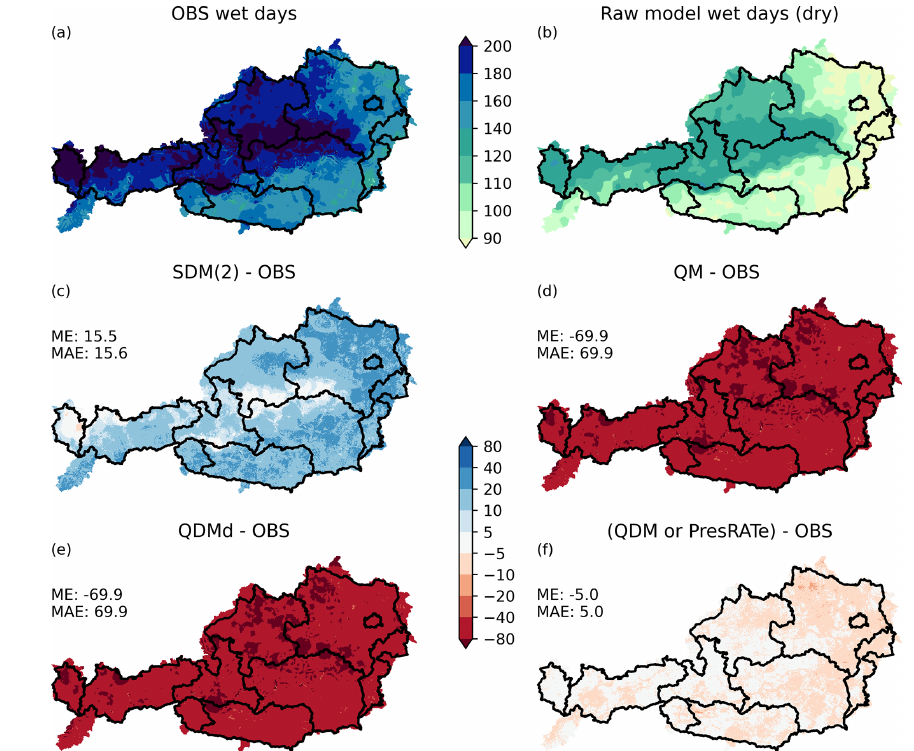
Figure 8. Wet days per year ( ≥ 0 . 1mm) in the historical period for dry model data. (a) Annual wet days in OBS. (b) Raw model annual wet